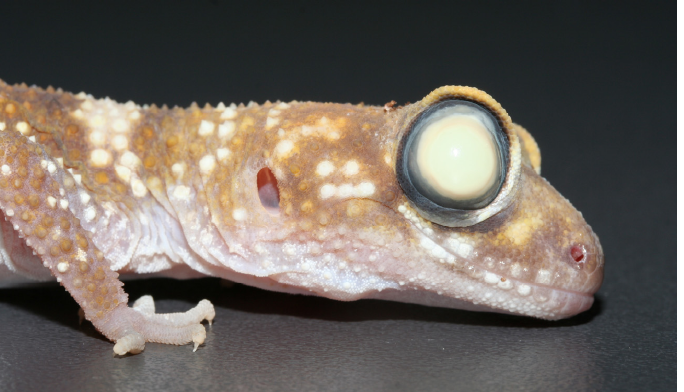
Figure 31. Thick-tailed gecko ( Underwoodisaurus milii ) with subspectacular abscess associated with bacterial infection.